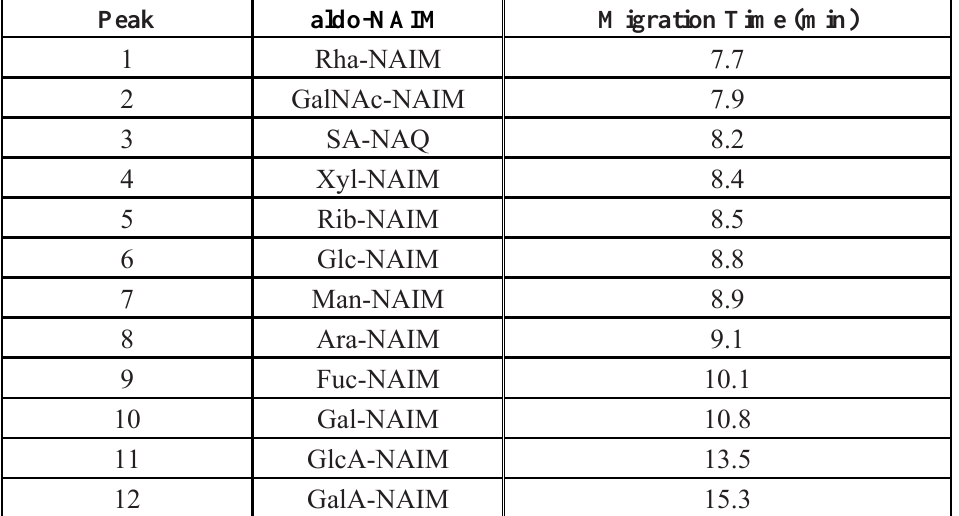
Table 1. The migration times of 2,3-naphthalene diamine derivated